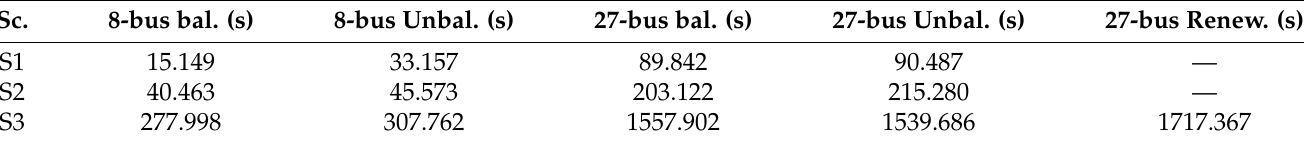
Table 29. Processing times expended by the DVSA in each test feeder and simulation case. Sc.